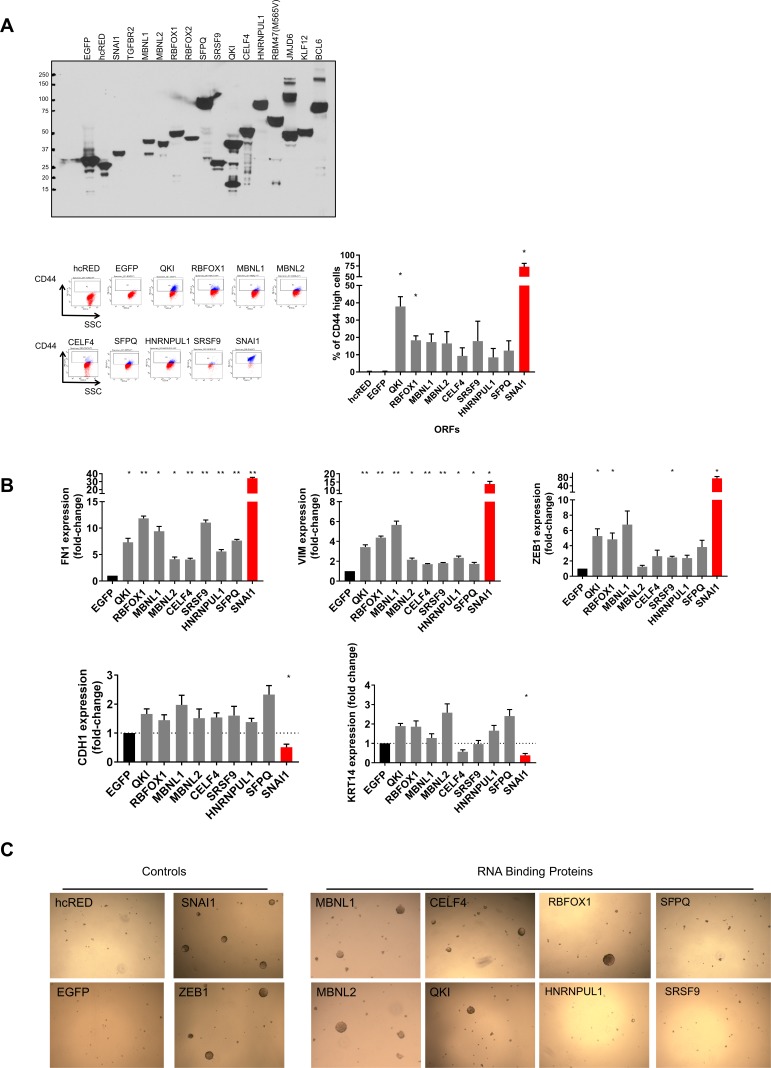
Functional validation of candidate RNA-binding proteins in cellular assays.(A) Validation of individual candidate ORFs by CD44 status. (Upper) Immunoblot analysis of ORF expression. The ORFs were tagged with a V5 epitope in the lentiviral expression vector (the TGFBR2 ORF contains a termination codon before the V5 tag). The expression of the indicated ORFs were analyzed using a V5 antibody. (Lower left) Flow cytometry plots of CD44 staining. The y-axis shows CD44 staining while the x-axis shows side scatter (SSC). (Lower right) Quantification of the percentage of CD44 high cells. n = 3, *, p<0.05, Student’s two-tailed t-test. (B) Change in the expression of mesenchymal (FN1, VIM, ZEB1) and epithelial (CDH1, KRT14) markers in HME cells expressing splicing factors normalized to a negative control (EGFP). Cells expressing SNAI1 served as a positive control. Fold-changes in gene expression were quantified by qPCR in cells that expressed the corresponding ORFs (data corresponds to heatmap in Figure 2A). n = 3. *, p<0.05; **, p<0.01, student’s two-tailed t-test. (C) Representative images of the mammospheres in HMLE cells that express the indicated ORFs as quantified in Figure 2C.